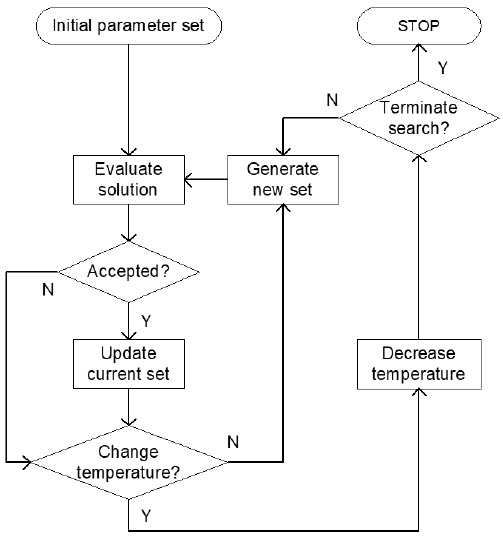
Figure 7. Simulated Annealing flow chart